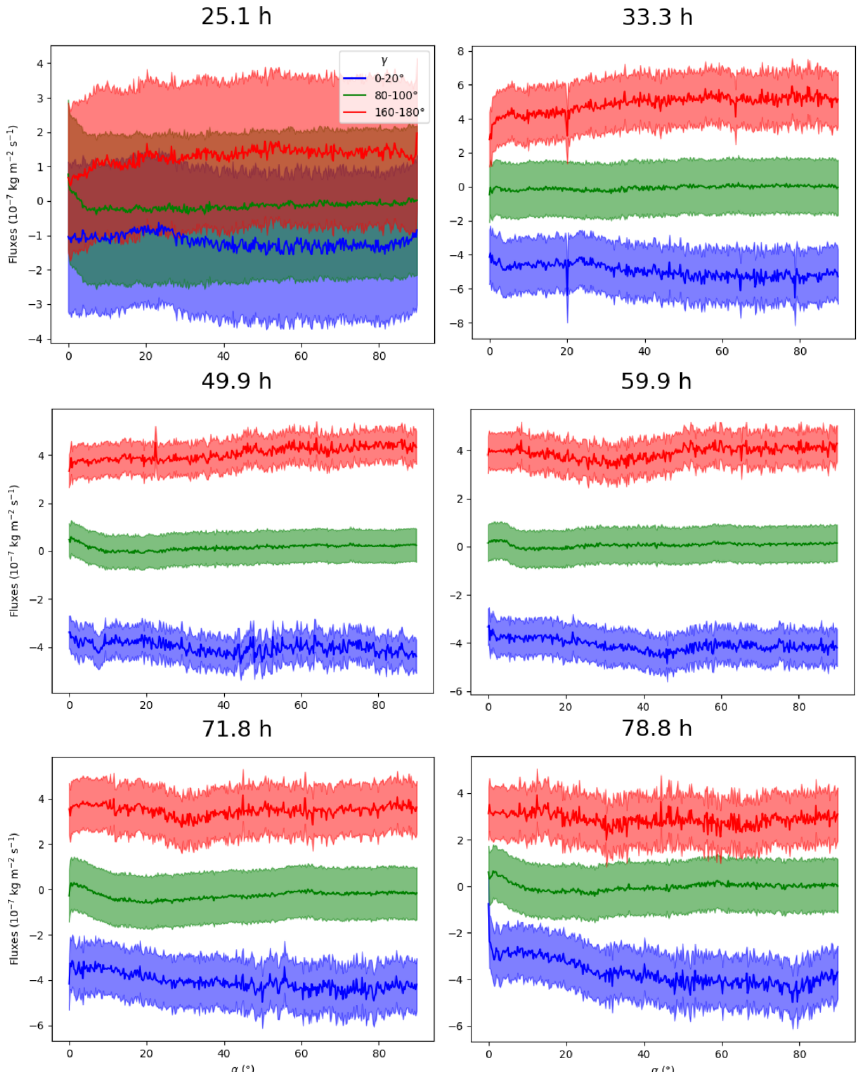
Figure 19. Mean fluxes against α = ( z , c ) , for γ ∈ [ 0 , 20 ◦ ] (faces oriented upward), γ ∈ [ 80 , 100 ◦ ] (face oriented vertically) and γ ∈ [ 160 , 180 ◦ ] (face oriented downward). Shaded areas correspond to associated uncertainties, coming from the measurement of the interface displacement between two images and estimated to be one voxel, i.e.